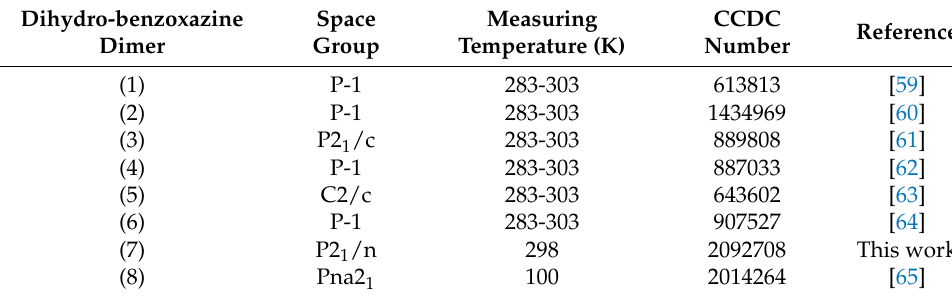
Figure 5. Powder XRD patterns of the dihydro-benzoxazine dimers. Table 5. Space groups of the dihydro-benzoxazine